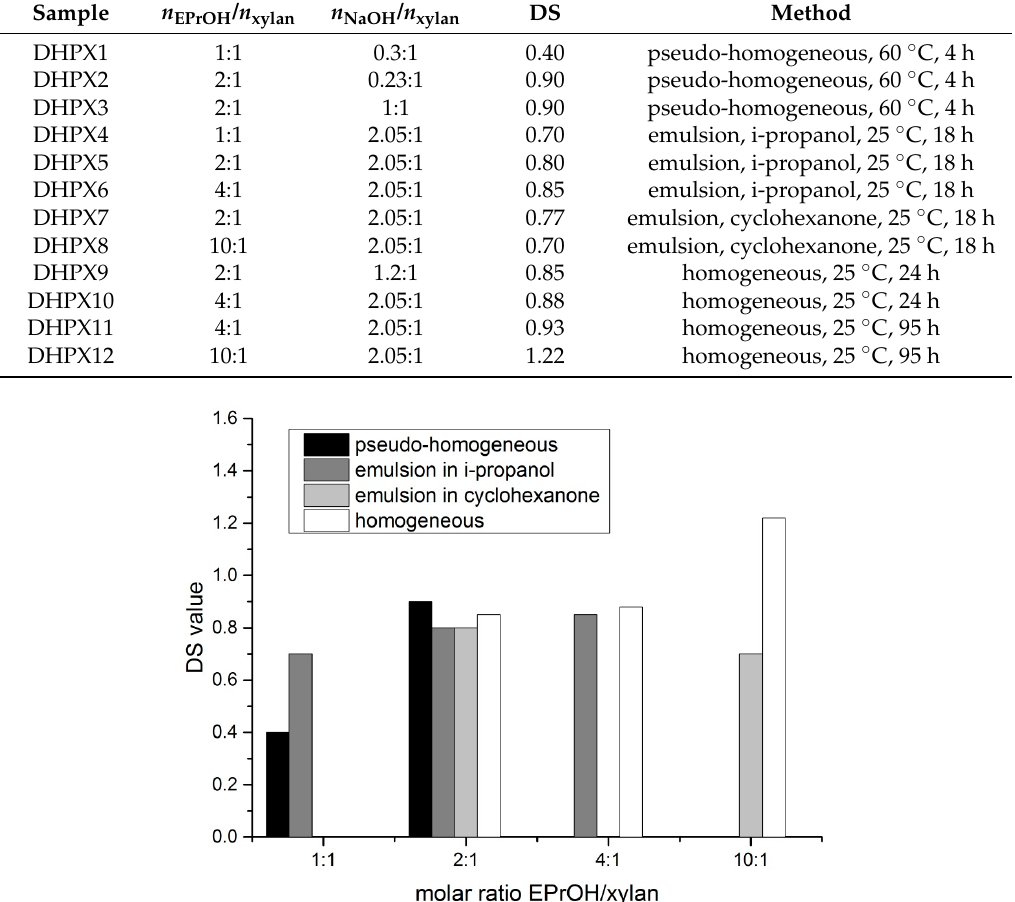
Figure 3. Effect of the reaction conditions on the degree of substitution (DS) values of xylan, achieved with 2,3-epoxy-1-propanol.